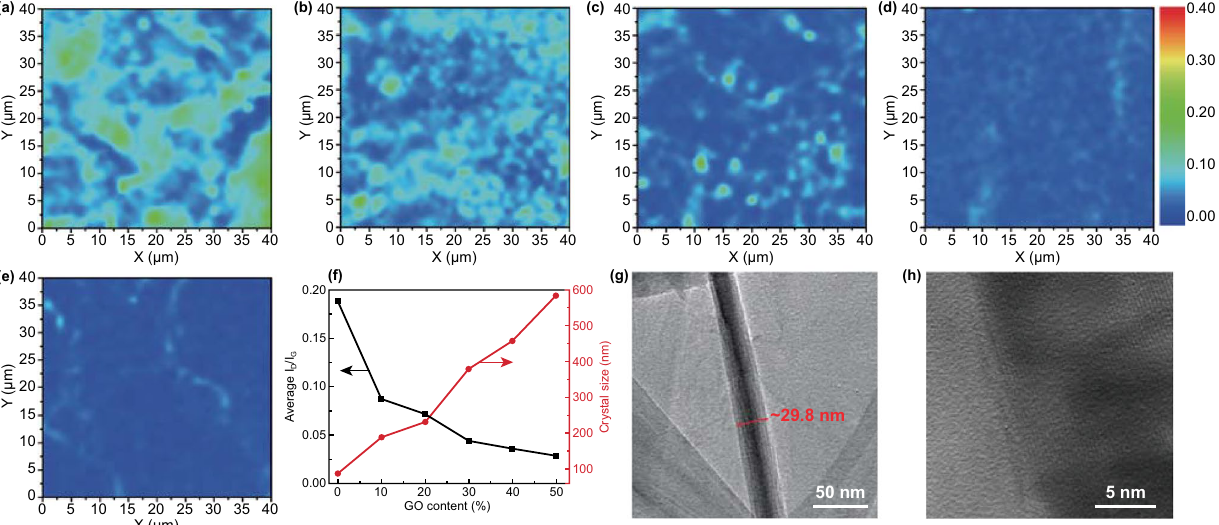
Fig. 3 Raman mappings of a G9P1‑2800, b G8P2‑2800, c G7P3‑2800, d G6P4‑2800, and e G5P5‑2800. f Plots of average I D /I G value and crys‑ tal size of LSGAs as a function of GO content in PAAS/GO suspensions. g TEM and h HRTEM images of